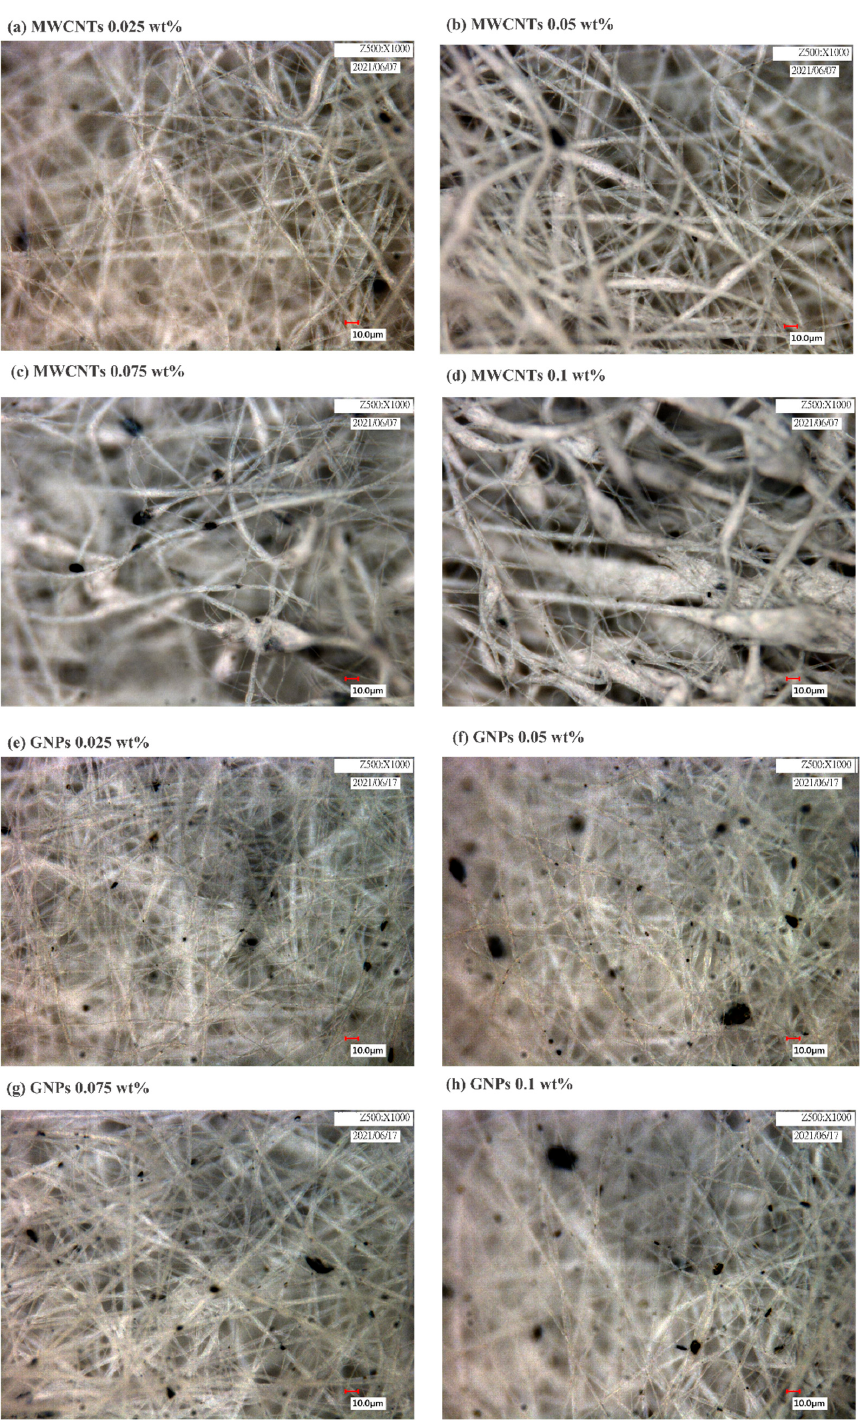
Figure 4. Optical microscope photographs demonstrating microstructural characterization of the electrospun polyvinylidene fluoride composite fibers with varying carbon nanotube content—( a ) 0.025, ( b ) 0.05, ( c ) 0.075, and ( d ) 0.1 wt%—or graphene nanoplatelet content—( e ) 0.025, ( f ) 0.05, ( g ) 0.075, or ( h ) 0.1 wt%.